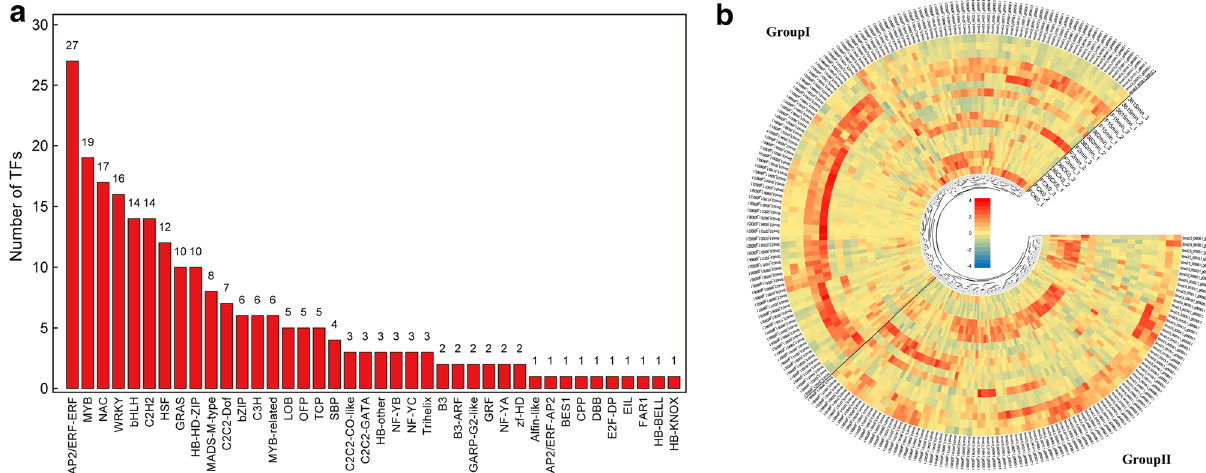
Figure 7. ( a ) Number of transcription factors (TFs) involved in fresh-cut eggplant browning. ( b ) Heat map presenting the expression patterns of different TFs in response to diverse treatments. The heat map was drawn with pheamap (v1.0.12) (Kolde, R. pheatmap: Pretty Heatmaps, r package version 1.0.12 (2019). https:// CRAN.R- proje ct. org/ packa ge= pheat